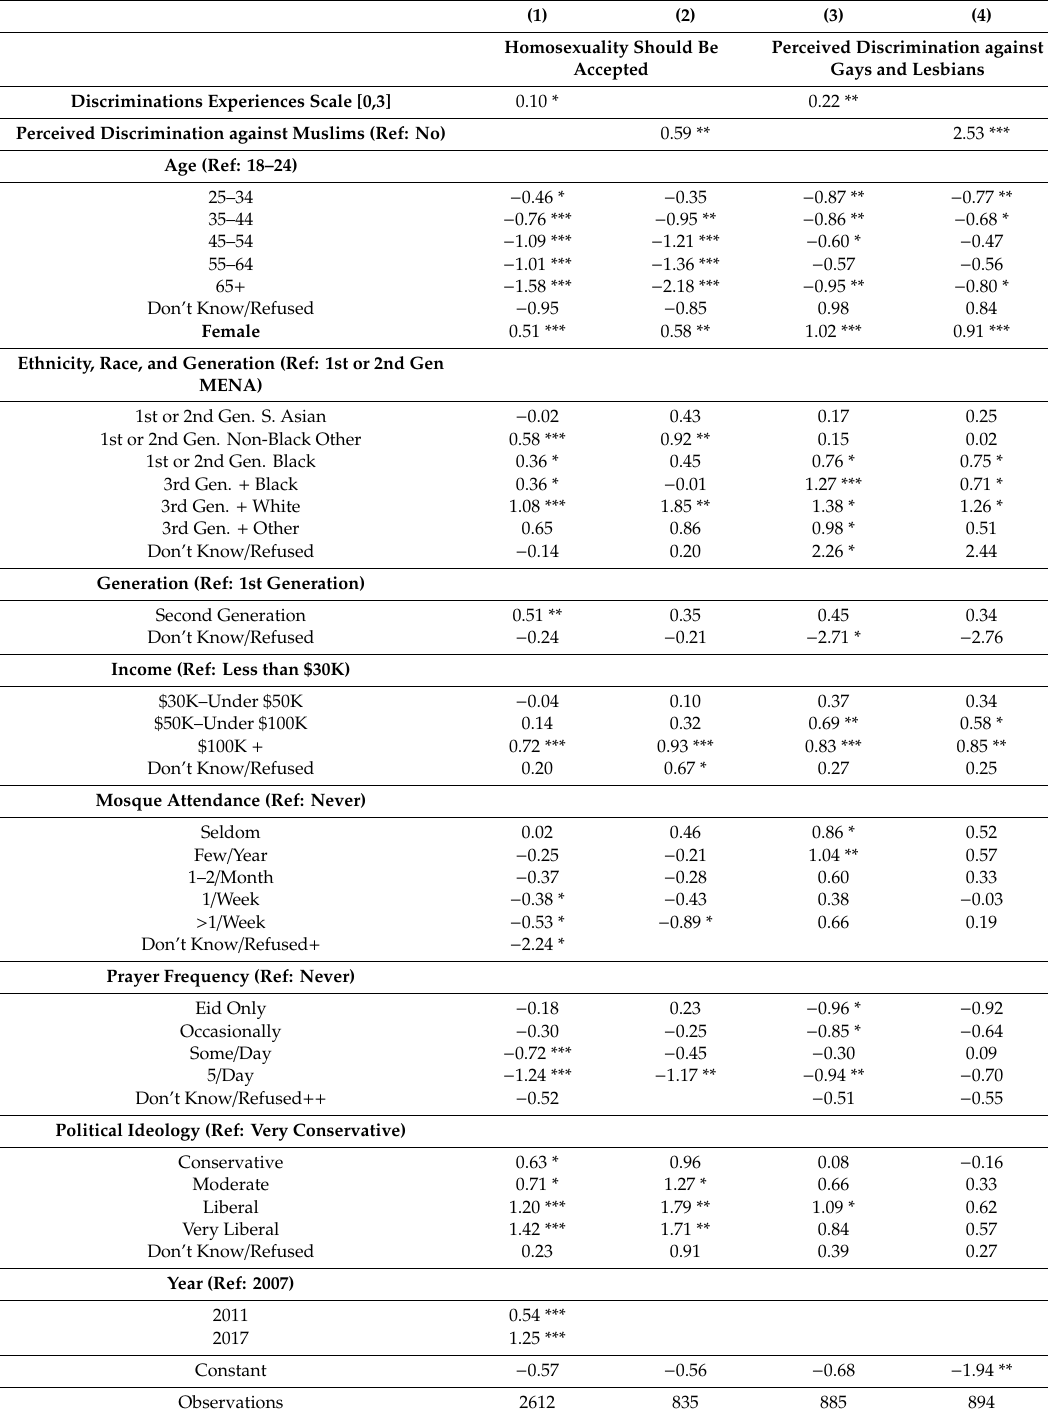
Table 3. Coe ffi cients from Logistic Regression Predicting Solidarity with Gays and